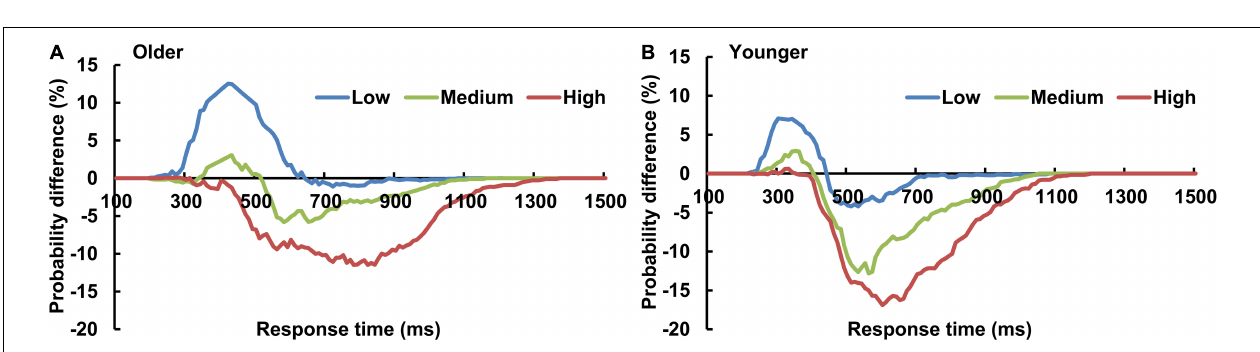
FIGURE 4 | Significant audiovisual facilitation effect was mainly found in the low visual perceptual-load conditions (A) , but depression effects were found in the medium (B) and high (C) visual perceptual-load conditions. The AVI was delayed for older adults than that for younger adults under all visual perceptual-load conditions. (D) Low, low visual perceptual-load condition; Medium, medium visual perceptual-load condition; High, high visual perceptual-load condition. *** p < 0.001.